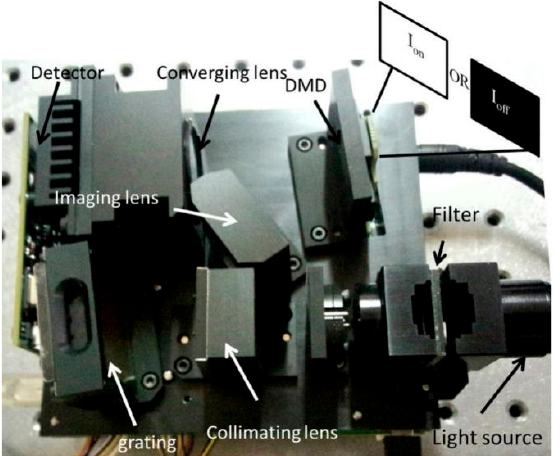
Figure 1. The prototype of stray light measurement in a DMD-based spectrometer: the light from the light source passes through the collimating lens, grating, imaging lens, DMD, and converging lens to the detector. When all the micro-mirrors are in the “on” state and “off” state, the detected light signals I on and I off can be derived, respectively.